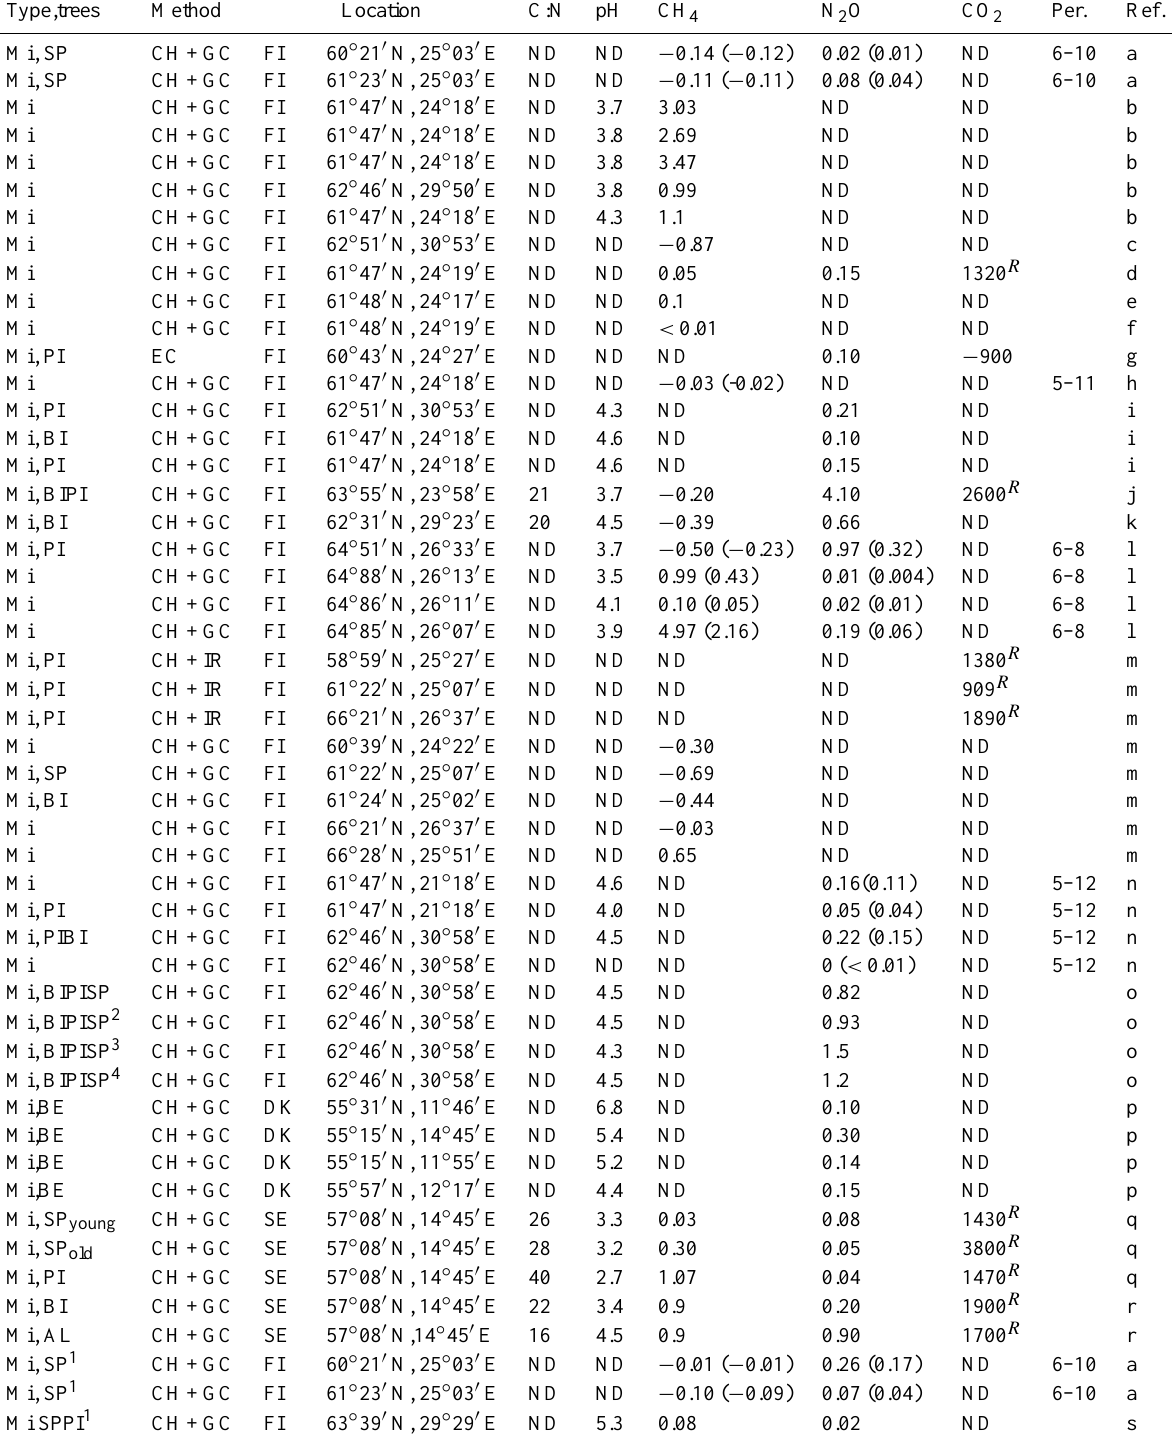
Table 2. Annual balances of CH 4 (gm − 2 yr − 1 ), N 2 O (gm − 2 yr − 1 ) and net ecosystem CO 2 exchange (gm − 2 yr − 1 , R =only forest floor respiration) from forestry drained peatlands and restored (REF) forested sites in the Nordic countries (DK=Denmark, FI=Finland, SE=Sweden). Peatland types are Om=ombrotrophic peatland or Mi=minerotrophic peatland. Tree species were spruce (SP), beech (BE), alder (AL), pine (PI) or birch (BI). A negative value indicates uptake, a positive value indicates emission. Methods are CH=chamber, GC=gas chromatograph, IR=infra-red analyzer and EC=Eddy covariance method. If annual emission is estimated based on seasonal results the original measuring period (months from-to) is shown in column “Per.” and the original emission value for that period in